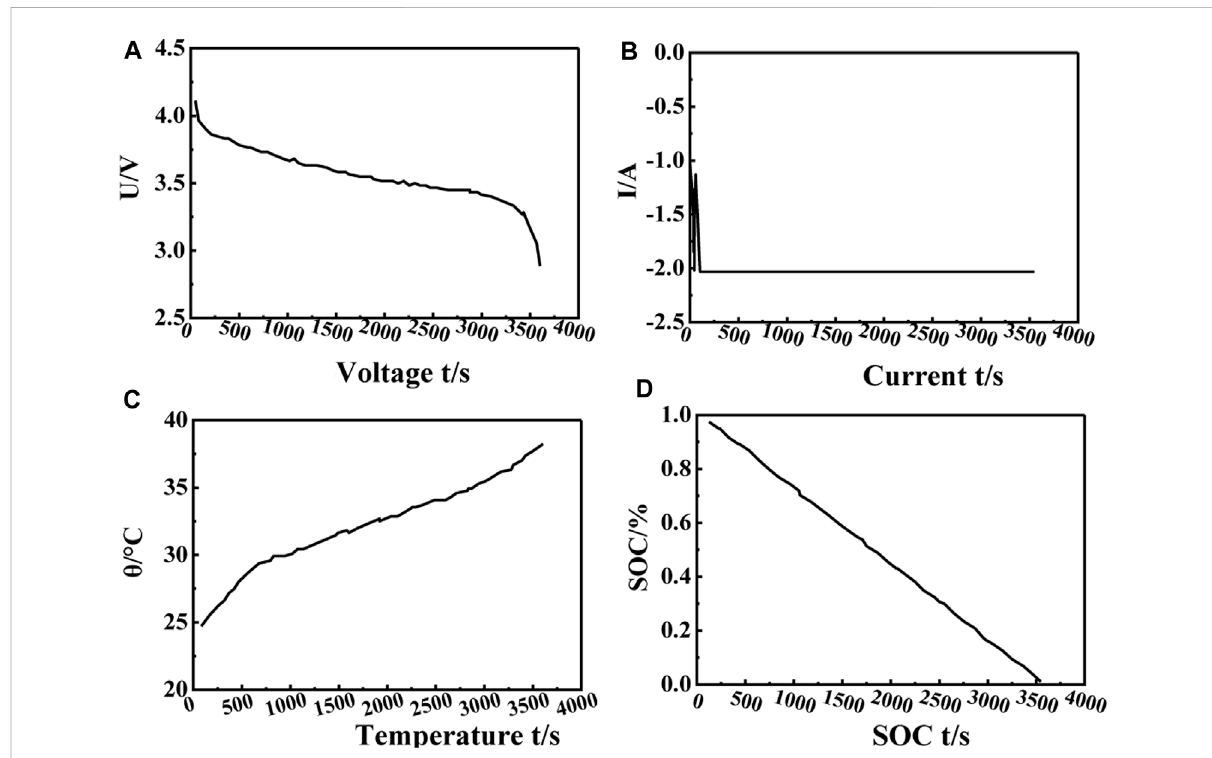
FIGURE 1 Discharge data. When the current is constant, the voltage drops slowly with time, and at 3500s, the voltage reaches 2.8 V. The temperature gradually increased with time, and the highest value could reach 3.7 ° C. The SOC value increases with time, from the initial 0.92 to 0 at